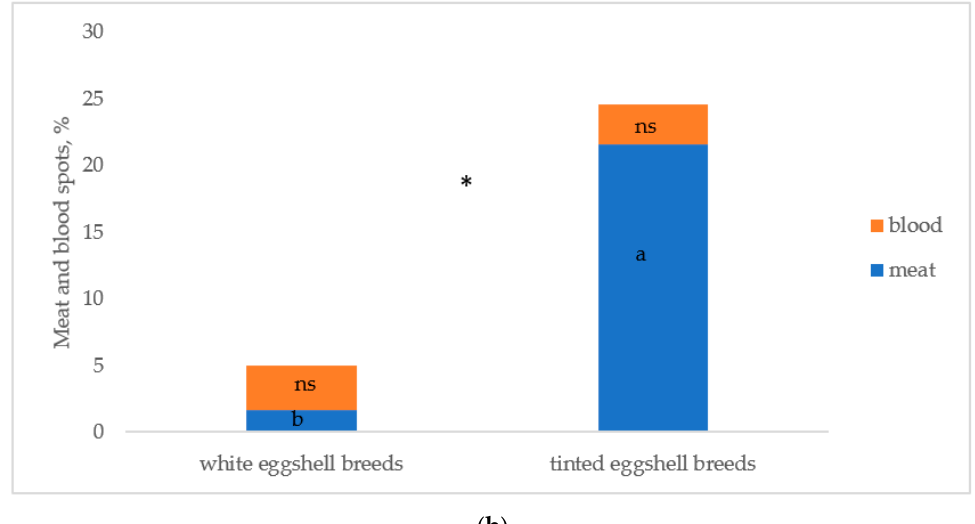
Figure 5. Albumen and yolk inclusions for the ( a ) breeds and ( b ) white and tinted eggshell breeds (PO: Polverara; ER: Ermellinata di Rovigo; PA: Padovana; PP: Pepoi; RL: Robusta Lionata; RM: Robusta Maculata). Different letters between breeds ( a ) and between the same colours of white (PO, PA) and tinted (PP, ER, RM, RL) eggshell breeds ( b ) indicate statistically different values (a,b,c: p < 0.05; ns: not significant). Statistical difference between white and tinted eggshell breeds ( b ) is indicated (*: p < 0.05). Observations ( n ) = 60 per breed ( a ); observations ( n ) = 240 per eggshell colour group ( b ).